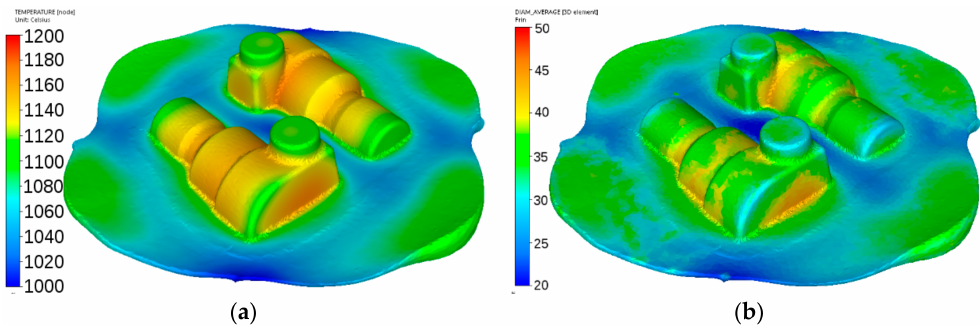
Figure 18. Calculated distributions of the temperature ( ◦ C) ( a ) and austenite grain size ( µ m) ( b ) after forging of the adapter from steel A.